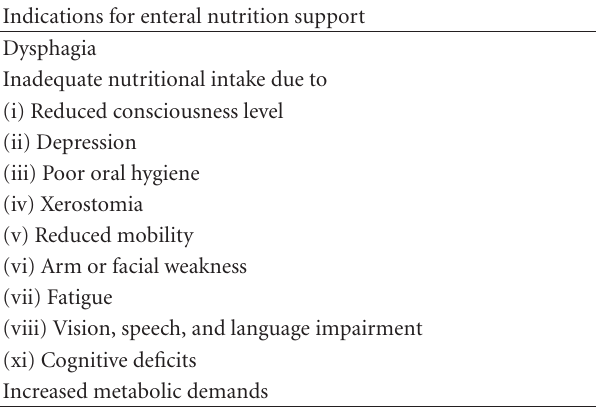
Table 2: Indications for enteral nutrition support in stroke